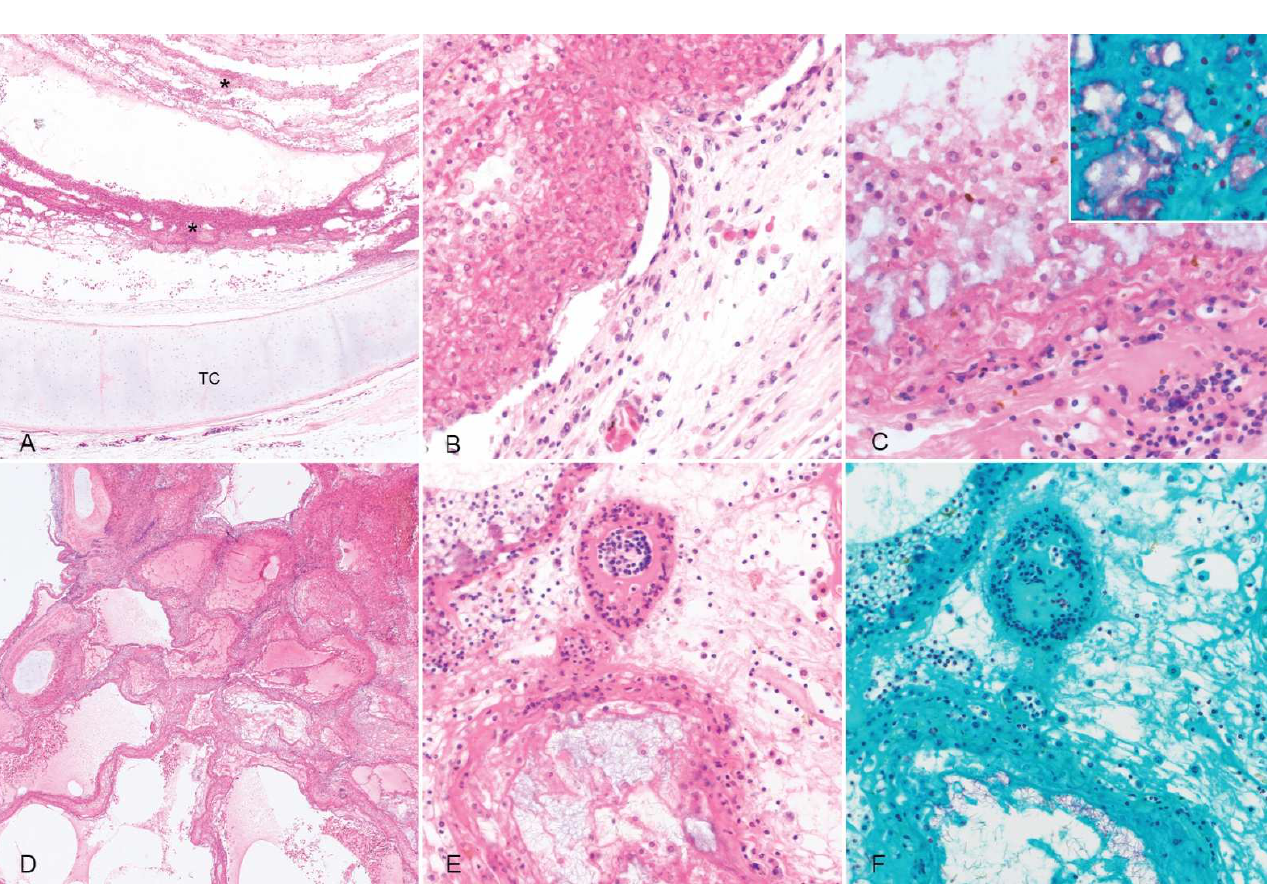
Figure 2. Histopathology. ( A ) Trachea. The mucosa is ulcerated and replaced by a diphtheritic membrane composed of lamellated layers of fibrin and necrotic cell debris (*). The denuded tracheal cartilage (TC) is located at the lower margin of the figure. Hematoxylin and eosin (HE). ( B ) Higher magnification image of the ulcerated tracheal mucosa. ( C ) Abundant elongated bacilli are scattered throughout the necrotic cell debris. Inset image: Bacteria are Gram-negative. Gram–Twort stain. ( D ) Lung. The pulmonary parenchyma is disrupted by extensive areas of acute necrosis, edema, and hemorrhage. HE. ( E ) A higher magnification image demonstrates severe interstitial edema and effacement of faveolar walls by fibrin and necrotic debris admixed with abundant bacilli. ( F ) A Gram– Twort stain of the same section demonstrates abundant delicate, elongated Gram-negative